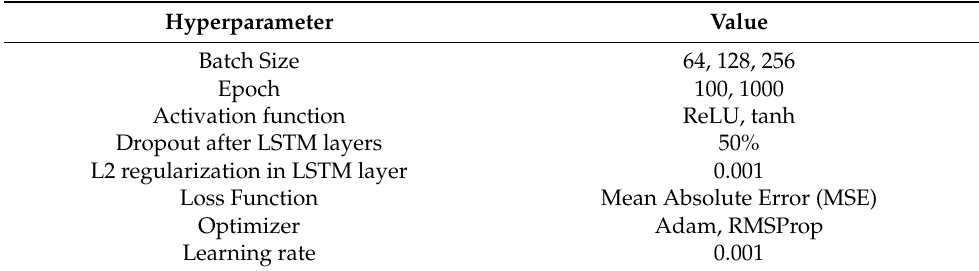
Table 4. Hyperparameter setting for the proposed model.